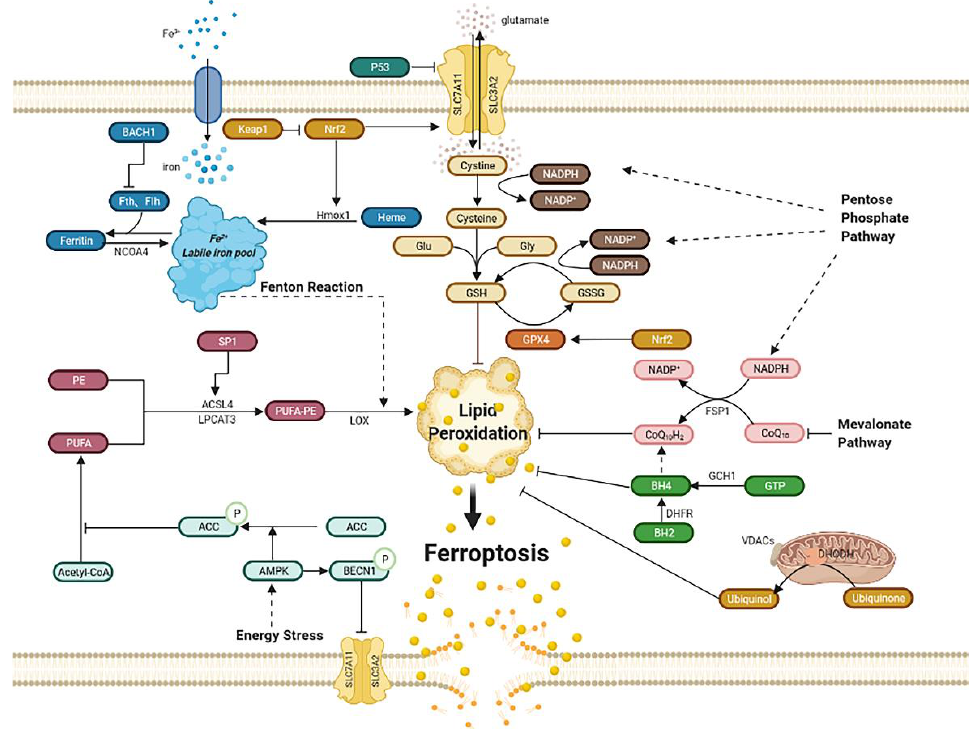
Figure 1. Regulatory pathways of ferroptosis. Ferroptosis is an iron-dependent, new kind of cell death. Regulatory pathways are complex, which can mainly be divided into several parts: iron me- tabolism; lipid peroxidation; Xc-GSH-GPX4 pathway; FSP1 – CoQ10 – NAD(P)H pathway; GCH1 – BH4 – DHFR pathway. Mitochondria and energy stress also play an important role. Abbreviations: